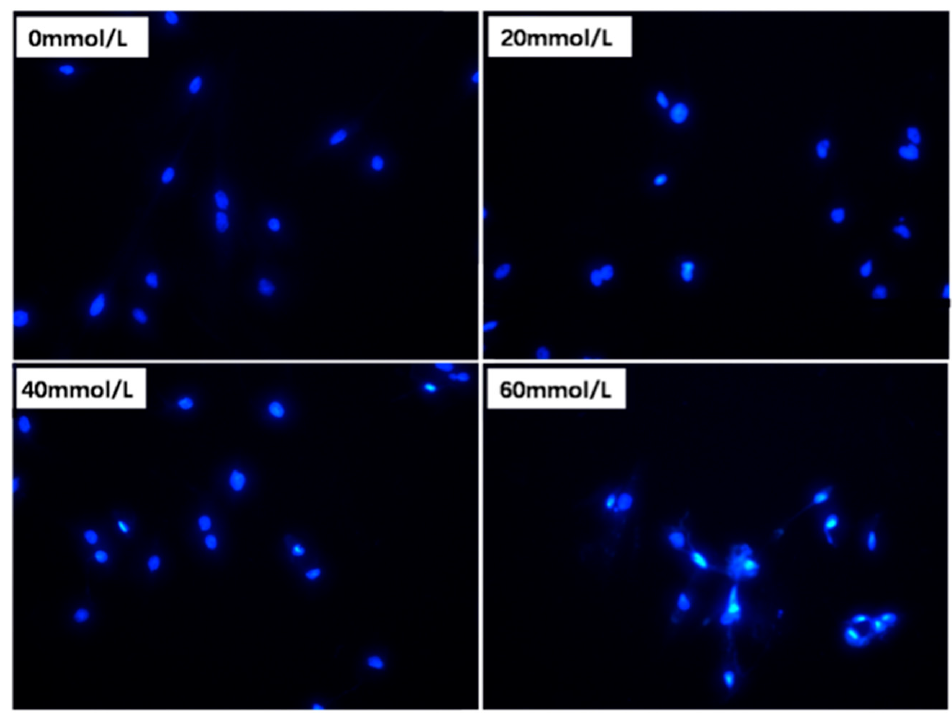
Figure 5. 2,5-HD-induced nuclei changes in pGCs detected by fluorescence microscopy. The pGCs’ nuclear division following treatment with 2,5-HD (0 mmol/L, 20 mmol/L, 40 mmol/L and 60 mmol/L) for 24 h was detected by DAPI staining. Scale bar 200 µm.